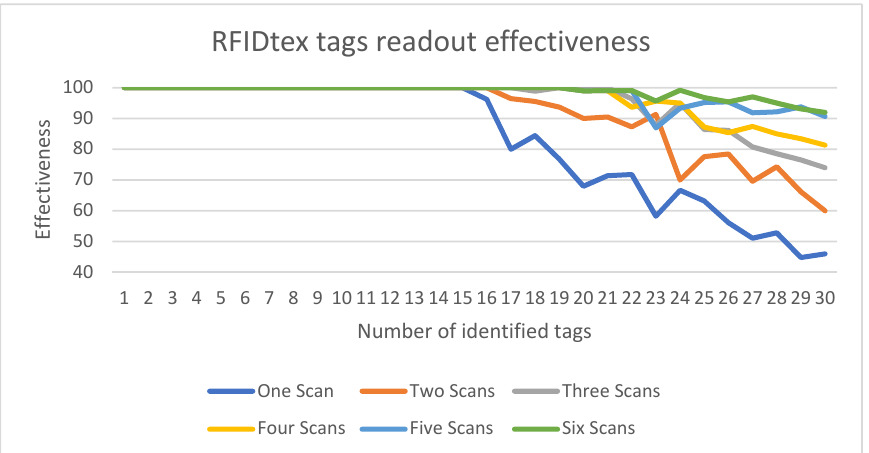
Figure 12. Developed device effectiveness as a function of the number of identified objects.